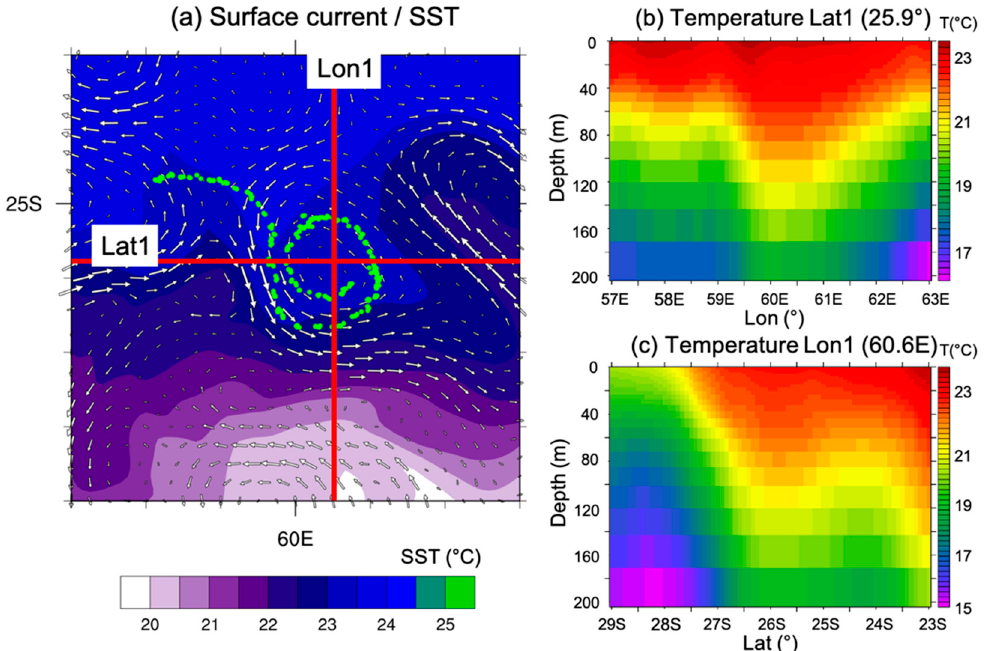
Figure 10. GLO12 model analyses in the area of evolution of ST Union averaged from 15 October to 15 December 2020. ( a ) surface currents and sea surface temperature superimposed on ST Union track over the 2 month period (green dots), ( b , c ) vertical cross-sections of ocean temperature through the center of the main vortex travelled by ST Union.